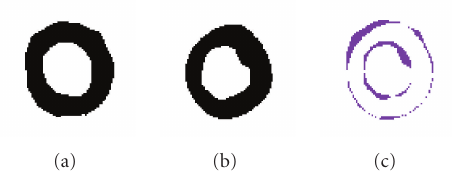
Figure 9: Detection mask obtained after segmentation of myocar- dial boundaries on a particular image: (a) expert’s mask (man- ual segmentation), (b) automatically segmented mask (presented method), and (c) superposition of both (dark surface stands for mismatched pixels of both